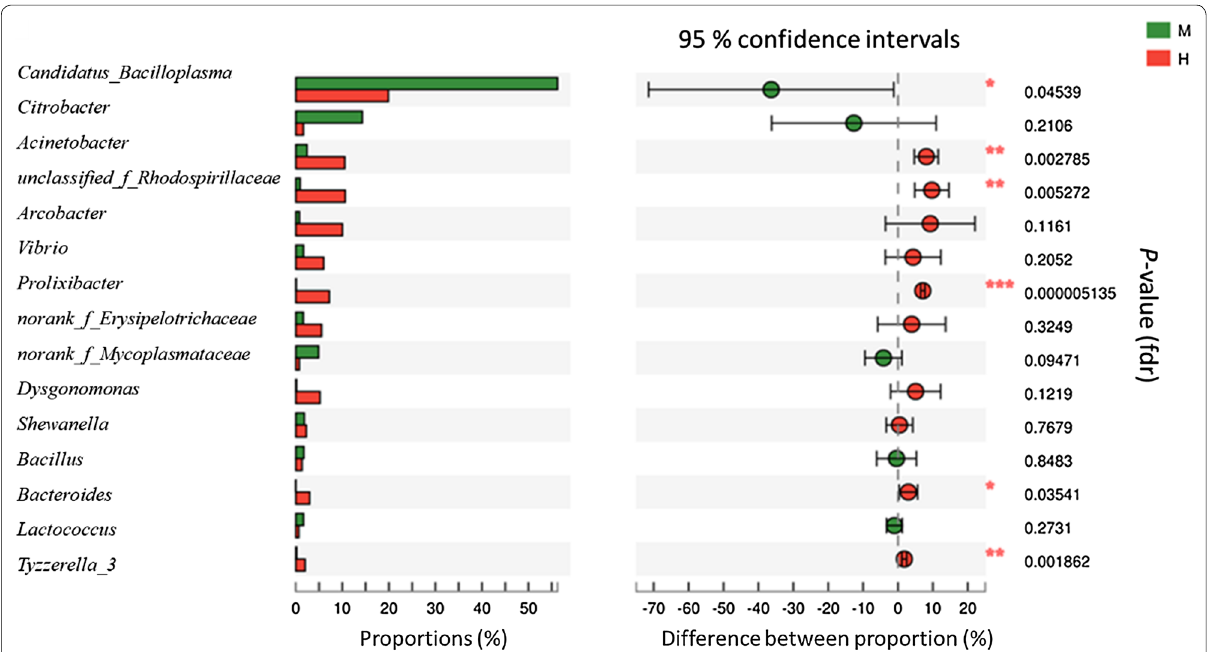
Fig. 2 Student’s t -test bar plot on genus level of bacterial communities in the intestinal tract samples. The ordinate indicates the name of the genus level, the abscissa represents the percentage of the abundance of the sample. The color of the bar represents different groups M: midgut (green), H: hindgut (red). 0.01 < P 0.05*, 0.001 < P 0.01**, P 0.001*** ≤ ≤ ≤